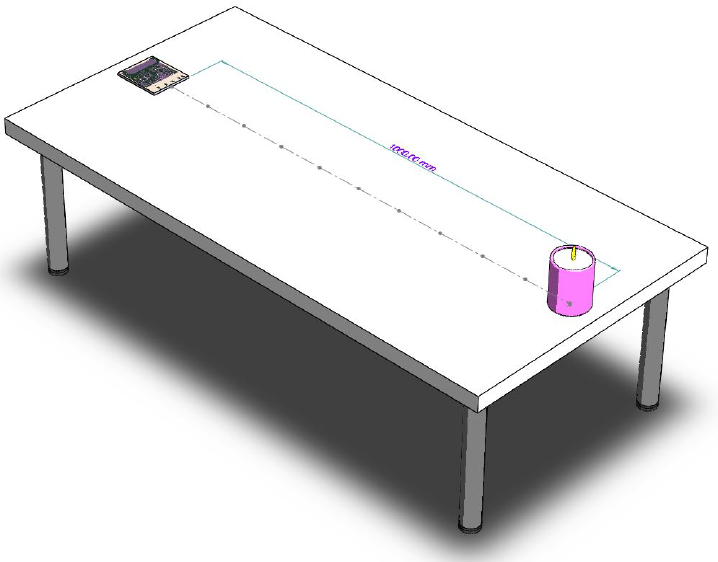
Figure 9. Illustration scenario in laboratory